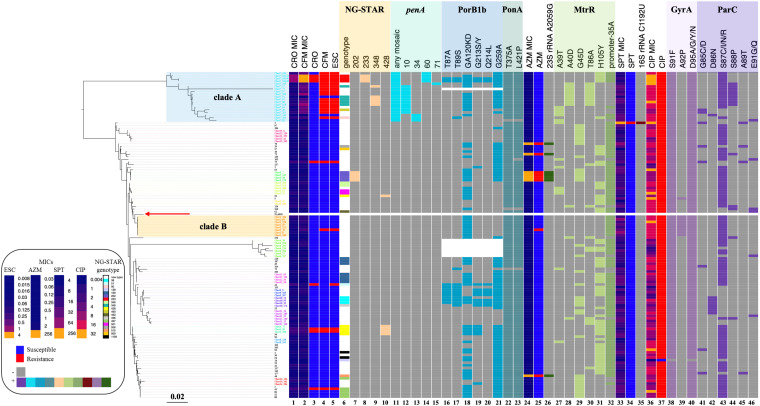
Phylogenetic reconstruction of nine genes, patterns of antimicrobial resistance, and genetic polymorphisms in 124 N. gonorrhoeae isolates. Left: Phylogenetic reconstruction of 124 isolates based on maximum likelihood. The red arrow indicates the reference strain FA1090. Heatmap. Columns 1 and 2: MIC values of CRO and CFM. Columns 3–5: Susceptible/resistant categories according to the EUCAST MIC breakpoints of CRO, CFM, and ESCs. Column 6: NG-STAR genotype (white band indicates NG-STAR genotypes new to the NG-STAR database). Columns 7–10: A specific NG-STAR genotype. Column 11: Any mosaic penA allele. Columns 12–15: A specific mosaic penA allele. Columns 16–21: Non-synonymous amino acid changes from wild type in PorB1b. Columns 22 and 23: Non-synonymous amino acid changes from wild type in PonA. Column 24: MIC values of AZM. Column 25: Susceptible/resistant categories according to the EUCAST MIC breakpoints of AZM. Column 26: A2059G mutation in 23S rRNA. Columns 27–31: Non-synonymous amino acid changes from wild type in MtrR. Column 32: The –35A deletion in the mtrR promoter. Column 33: MIC values of SPT. Column 34: Susceptible/resistant categories according to the EUCAST MIC breakpoints of SPT. Column 35: C1192U mutation in 16S rRNA. Column 36: MIC values of CIP. Column 37: Susceptible/resistant categories according to the EUCAST MIC breakpoint of CIP. Columns 38–40: Non-synonymous amino acid changes from wild type in GyrA. Columns 41–46: Non-synonymous amino acid changes from wild type in ParC. The purple and orange rectangles indicate clades A and B described in the text, respectively. Sequence names are colored by cluster.